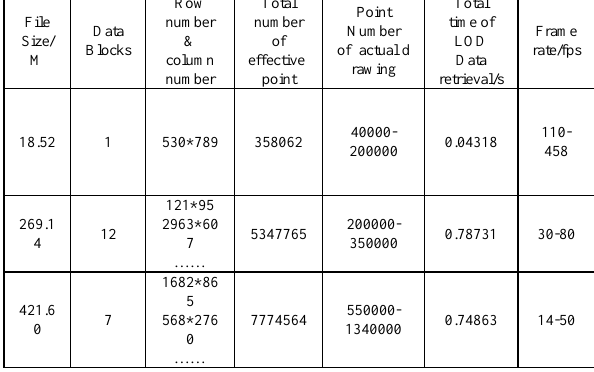
Table 2.Rendering efficiency statistics of point image model data using the proposed algorithm